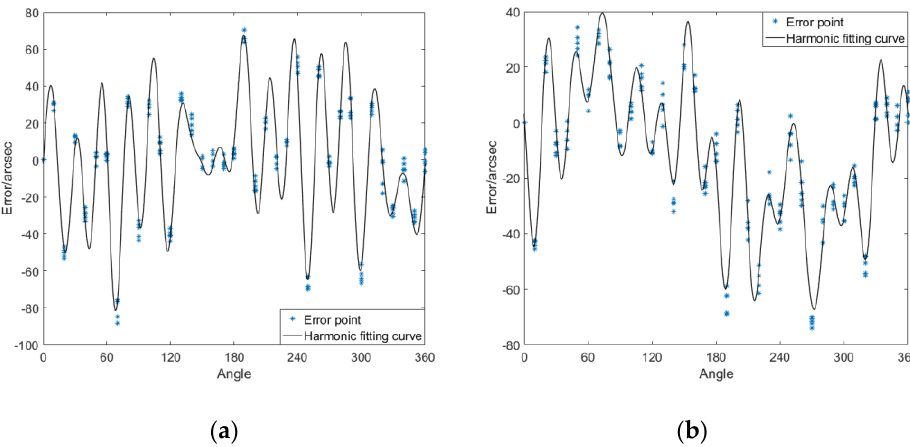
( b ) Figure 9. Before and after comparison of angle error compensation: ( a ) joint module a; ( b ) joint module b. Before the compensation, the peak values of error of joint modules a and b were 149.53 and 101.35 arcsec, respectively. After applying the error model compensation, any joint module angle error between 0–360° can be corrected. The peak values were reduced by 82.20% and 81.85%, to 26.62 and 18.40 arcsec, respectively. The angle measurement accuracy was significantly improved for the joint module whose internal structure was a magnetic encoder with limited precision. 5. Conclusions In this paper, the integrated joint modules in the robot are used as the driving joints of the self- driven AACMM and the angle errors of the joint modules are corrected by establishing the angle error model. The angle measurement error of the joint module is not only related to the encoder itself, but also influenced by the harmonic reducer. The high frequency component of the angle error is larger than that of the general circular grating sensor. The established error compensation model uses the method of eliminating the weak harmonic orders and retaining the strong harmonic orders in the 17 harmonic components, rather than, simply obtaining the first three harmonic orders, to make the fitting curve much closer to the actual error. The fixing mechanism for the calibration experiment was designed and manufactured. The mechanism is easy to install and its coaxiality is adjustable. The experimental data used for modeling were obtained and the angle error was reduced by 82.03% on average after compensation using the error model. This research will be helpful to improve the